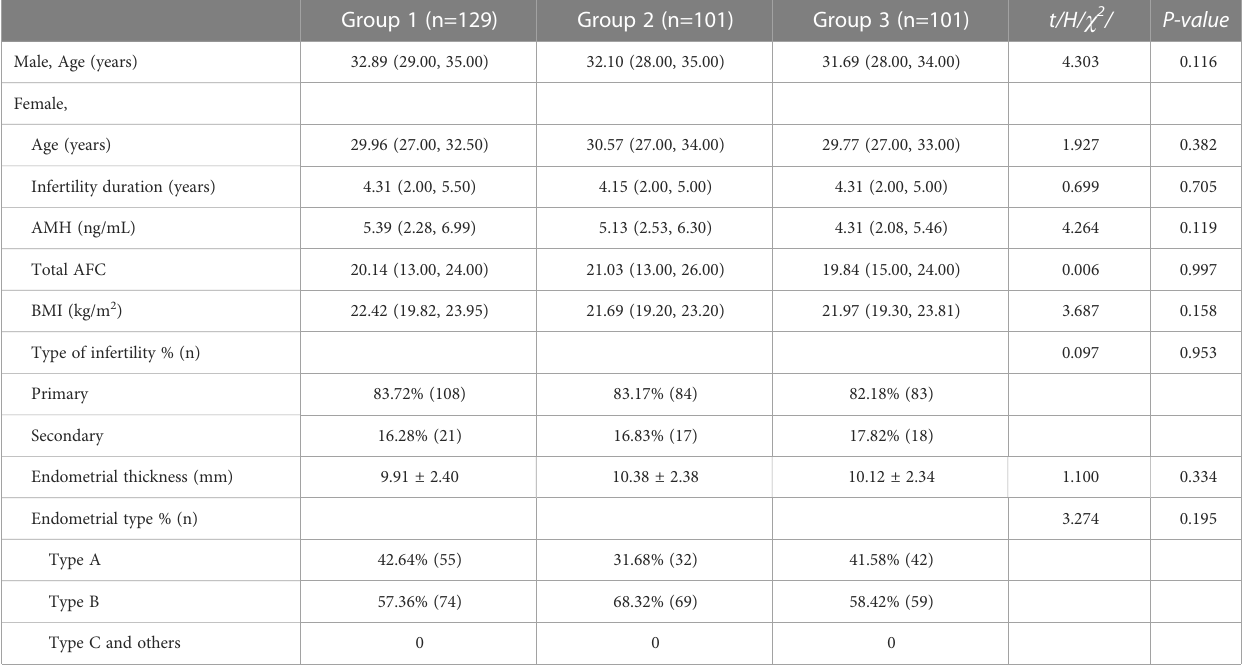
TABLE 1 Baseline characteristics of the patients enrolled in this study.